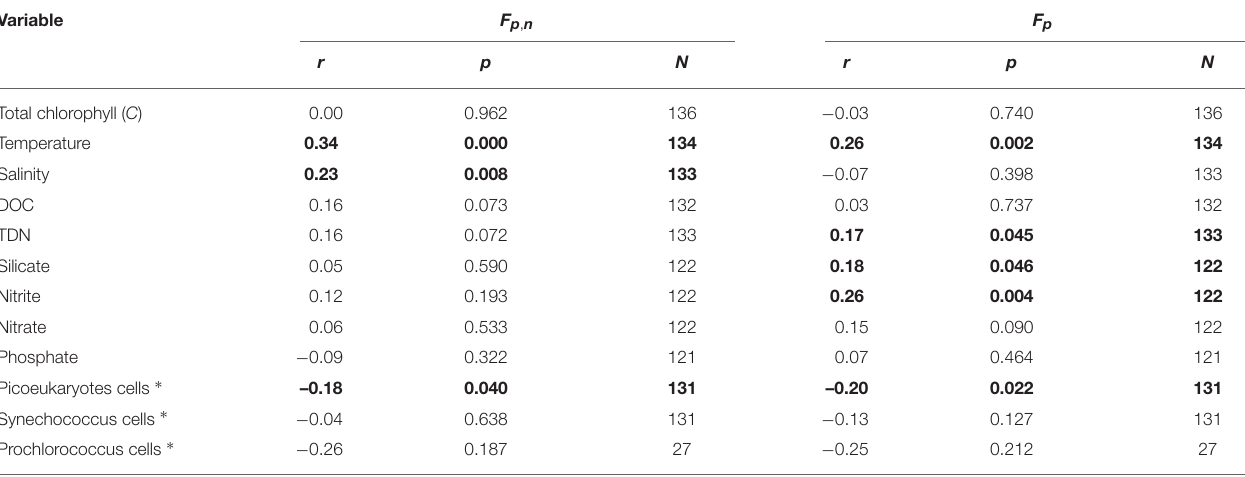
TABLE 4 | Correlations between model residuals (model minus measurements) in the fraction of total chlorophyll by combined pico- and nano-phytoplankton ( F p , n ) and picophytoplankton ( F p , cells <2 µ m) and other variables collected in the dataset. Variable F p ,